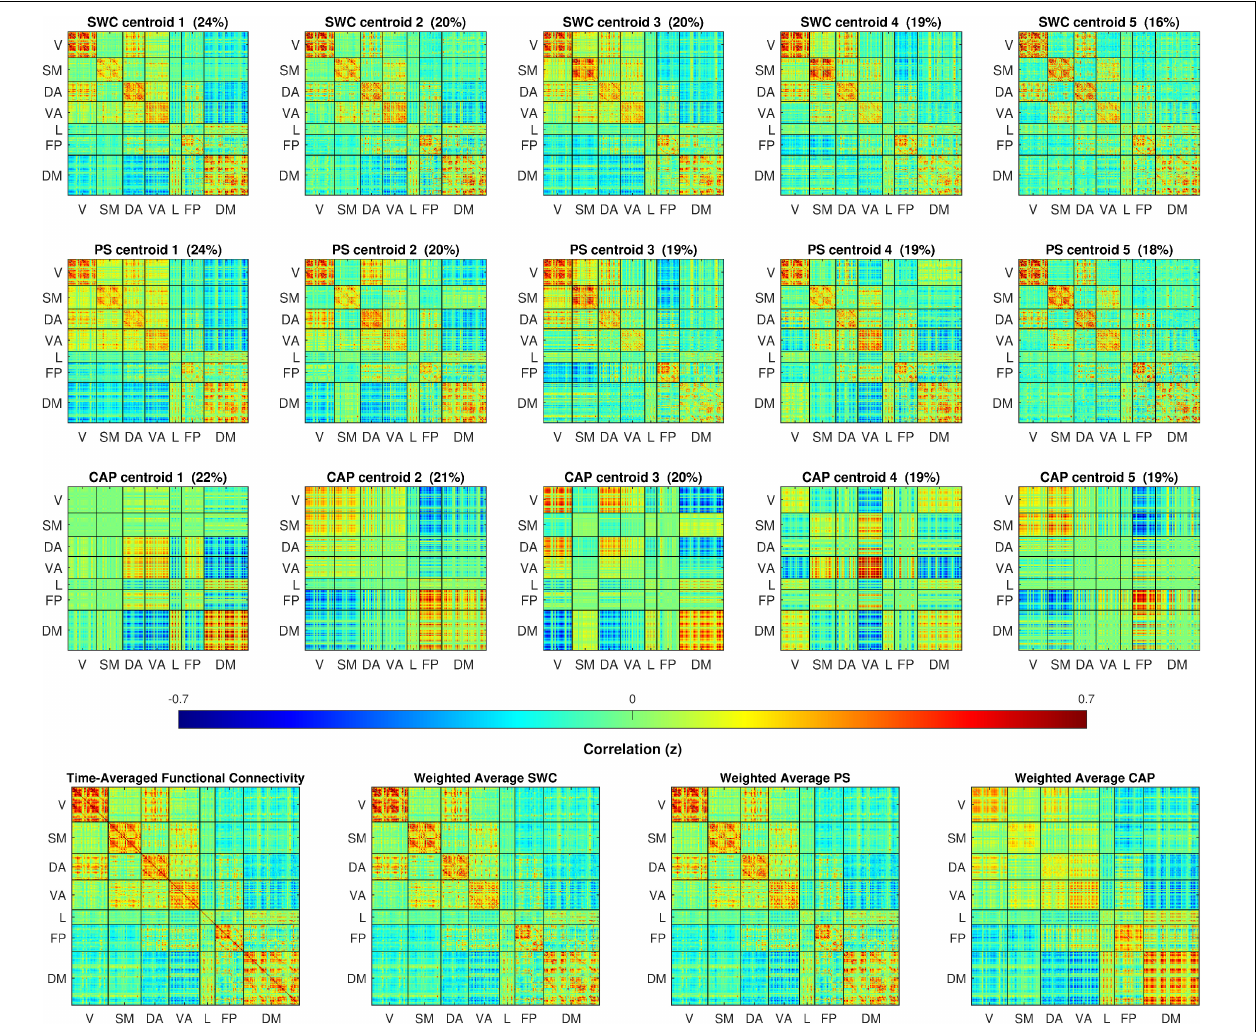
FIGURE 1 | The top three rows plot cluster centers colored by z-scores of correlation, cosine, and BOLD (BOLD amplitude squared) between parcel-pairs of sliding window connectivity (SWC), phase synchrony (PS), and co-activation pattern (CAP) clusters respectively. The clusters are sorted by occurrence rate (% shown above each centroid). The 360 spatial parcels are sorted into seven major functional networks identified by Yeo et al. (2014). The bottom row displays the time-averaged FC for the full dataset and the mean across cluster centers weighted by the occurrence rates for each dynamic method. The cluster weighted averages are correlated with time-averaged FC with r = 0.994, 0.998, and 0.873 for SWC, PS, and CAP methods respectively.